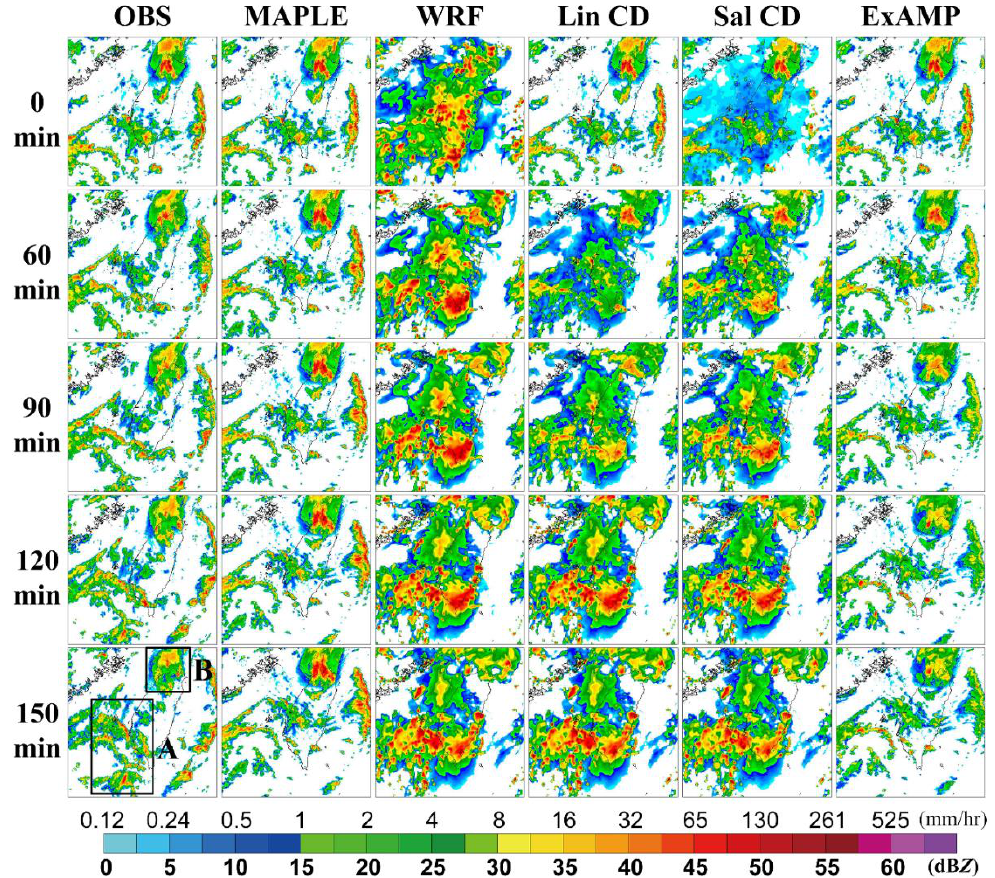
Figure 3. The reflectivity and corresponding rainfall rate of (from left to right ) the observations and the nowcasts of MAPLE, WRF, linear cross dissolve (Lin CD), salient cross dissolve (Sal CD), and extrapolation adjusted by model prediction (ExAMP) at the lead time of (from top to bottom ) 0, 60, 90, 120, and 150 min for a PL event at 10:00 UTC 2 July. Rectangles A and B highlight the discussed areas.